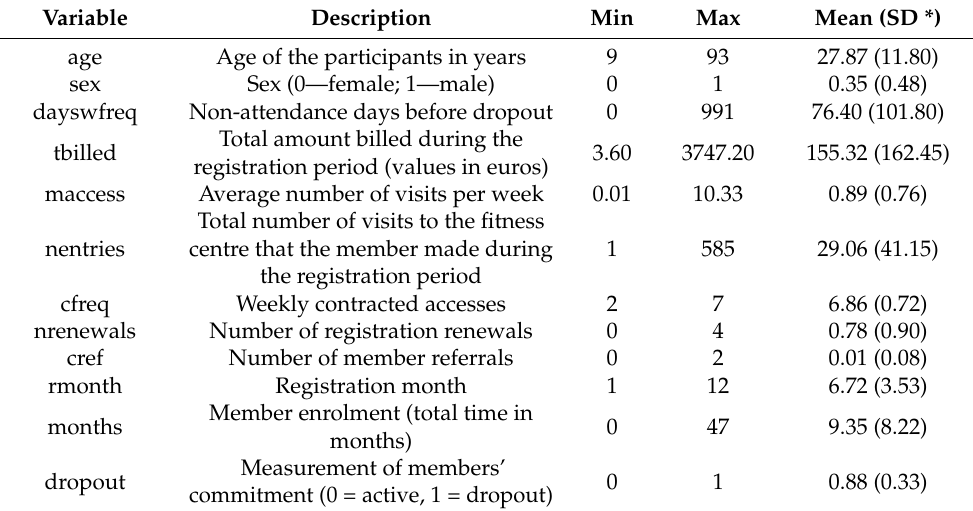
Table 1. Variables extracted for each subject of the sample and descriptive